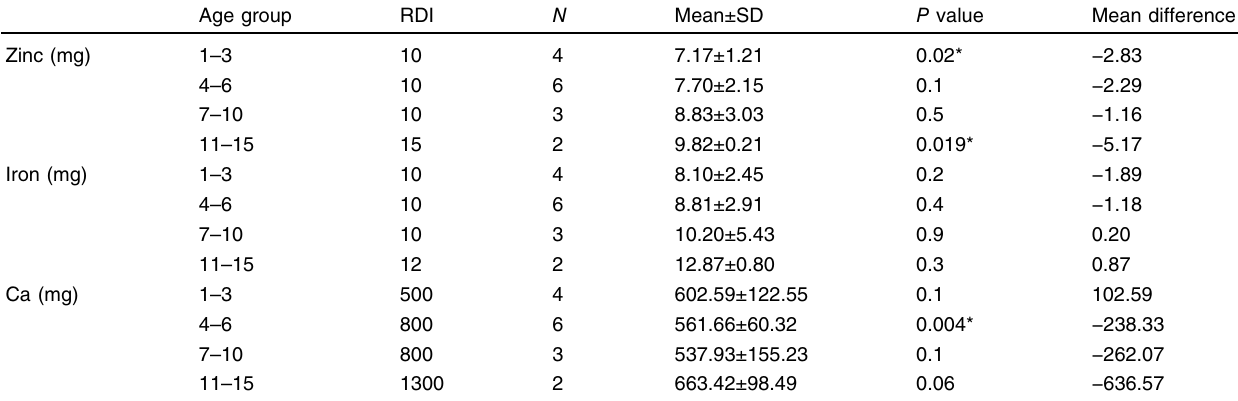
CF, cystic fibrosis; RDI, recommended daily intake. *Statistically significant.